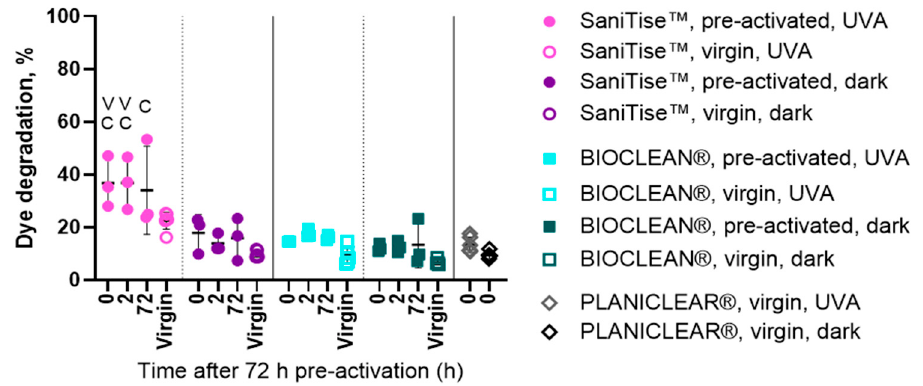
Figure 5. Photocatalytic effect of SaniTise™, BIOCLEAN ® , and PLANICLEAR ® (control) glasses according to 4 h methylene blue degradation assay. Virgin and UVA pre-activated glass surfaces (0 h: UVA pre-activated surface used immediately; 2: 2 h recovery of the surface after pre-activation; 72: 72 h recovery of the surface after pre-activation). The ‘V’ denotes significant difference from virgin surface of the same type in the same conditions ( p < 0.05); ‘C’ denotes significant difference from PLANICLEAR ® control surfaces in the same conditions ( p < 0.05).